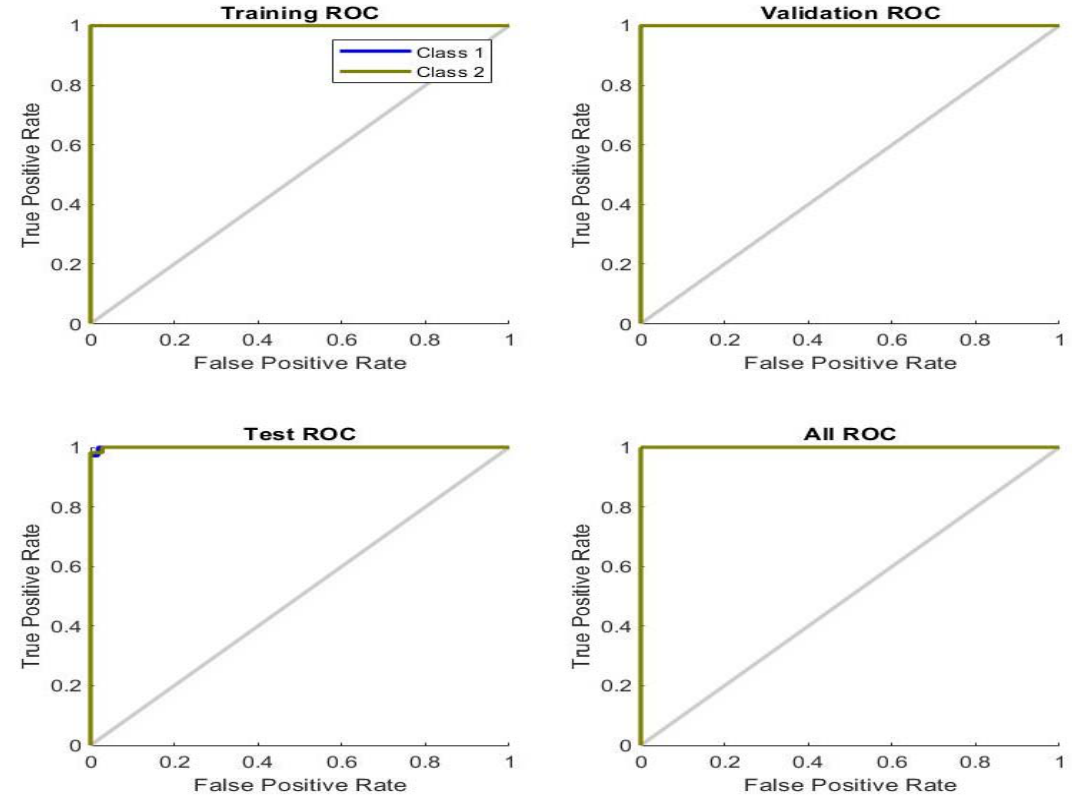
Figure 13. ROC plot of ASD dataset by